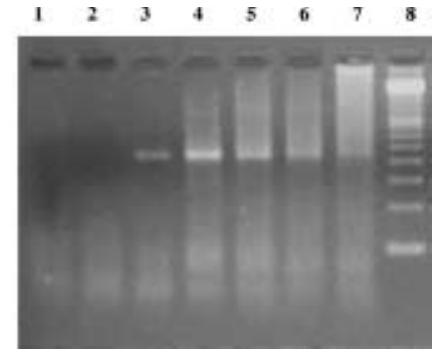
Fig. 1. PCR products generated by solution-phase RT-PCR after 10 (lane 1), 20 (lane 2), 30 (lane 3), 40 (lane 4), 47 (lane 5), 52 (lane 6) and 60 cycles (lane 7) in the agarose gel electrophoresis. Lane 8; 100 bp